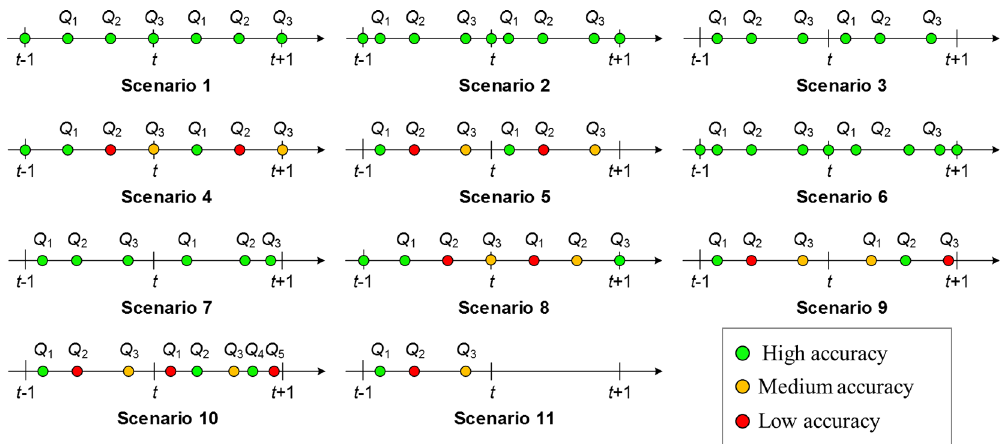
Figure 5. Experimental scenarios representing different configurations of arrival frequencies, number, and accuracies of streamflow crowd- sourced